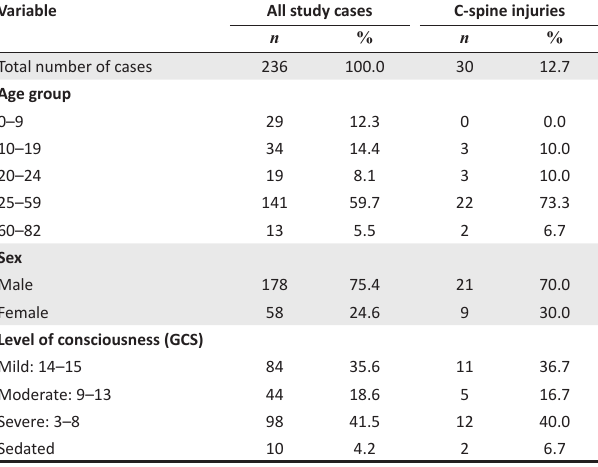
in the total study population ( n = 236) and the patients with a c-spine injury ( n = 30).